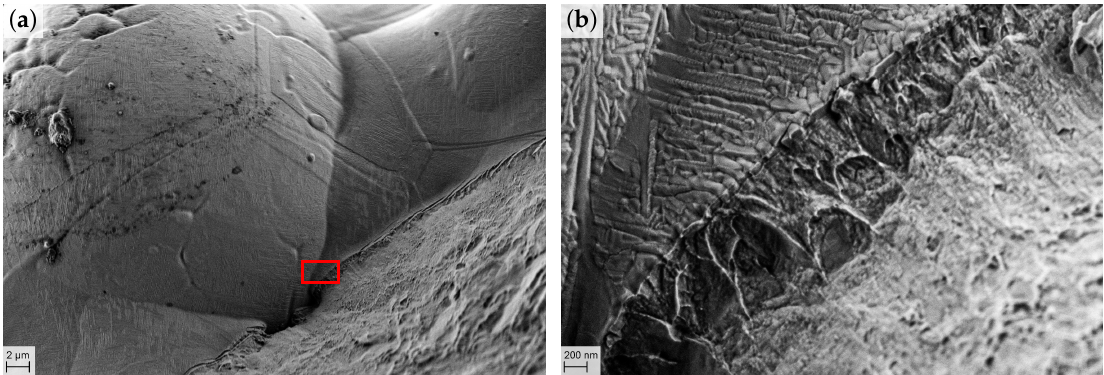
Figure 6. SEM analysis of the boundary surface of the test sample L10D06. ( a ) Semi-molten powder particle. ( b ) Magnification of ( a ) showing martensite columns on non fractured